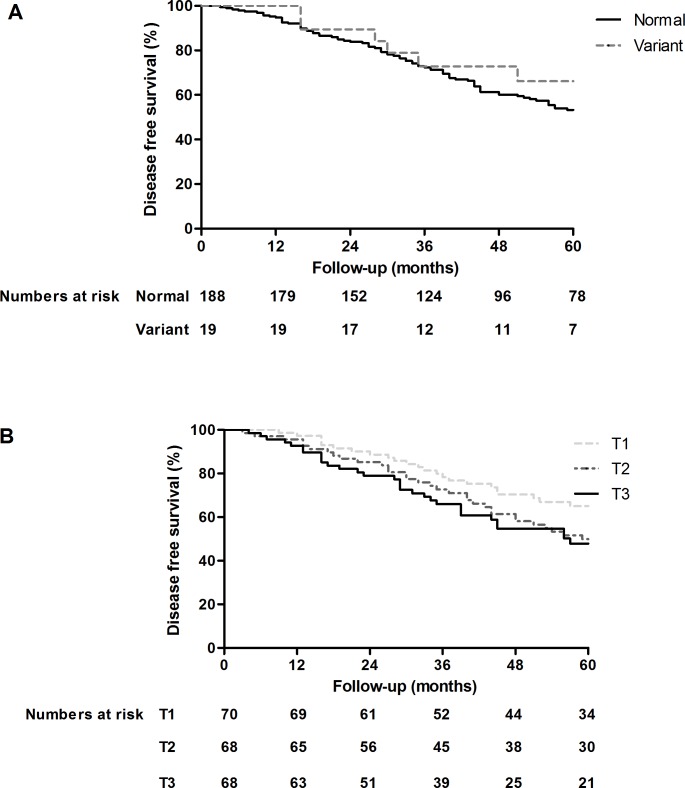
Relapse free survival for TPMT genotypes and tertiles of TPMT activity.Relapse free survival after start of cyclophosphamide induction therapy. Upper graph (3A): Variant = heterozygous TPMT variant carrier, Normal = normal genotype (wildtype TPMT). Lower graph (3B): T1 = lowest tertile, T2 = middle tertile, T3 = highest tertile of TPMT activity.